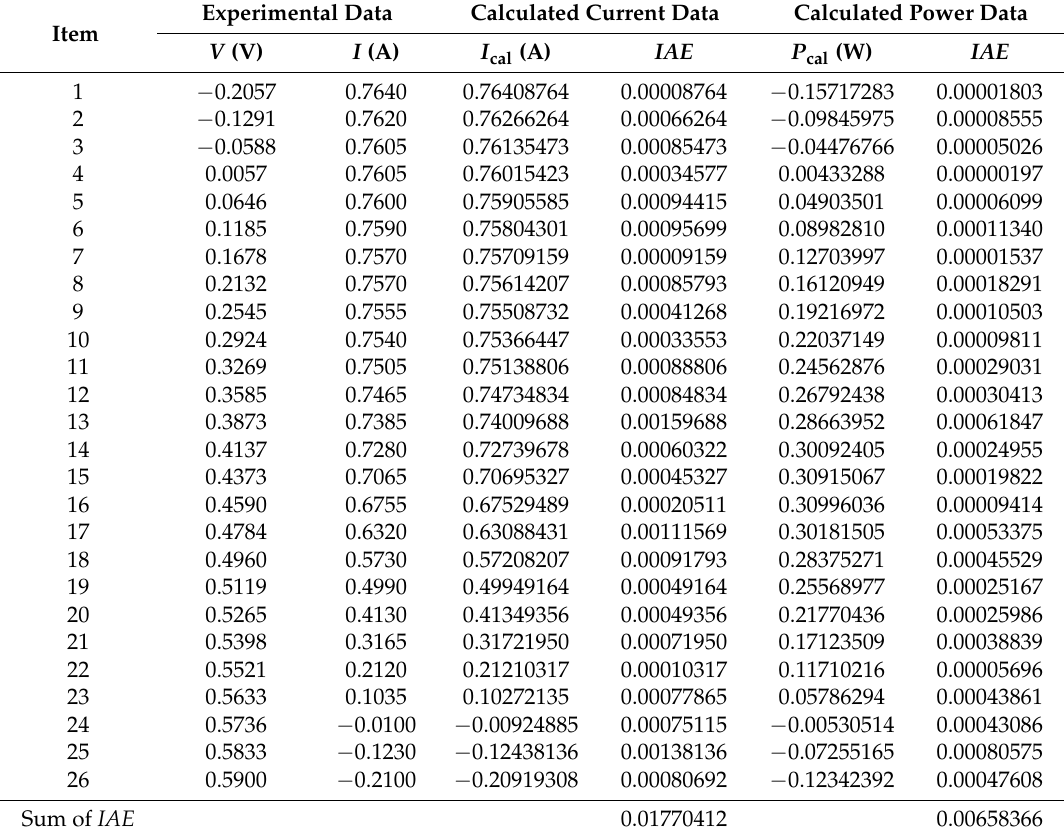
Table 3. The calculated results of the proposed ImCSA for the SDM of RTC France silicon solar